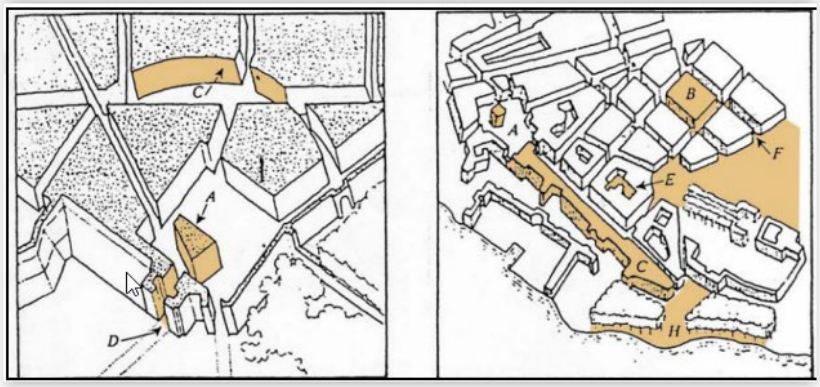
Figure 4 Distribution of urban solids and voids in urban space (A-Public buildings, B-Urban blocks, C-Boundary buildings, D- Passageways, E -Voids within the block, F- Pattern of boulevards and squares, H-Linear open spaces) (Trancik,